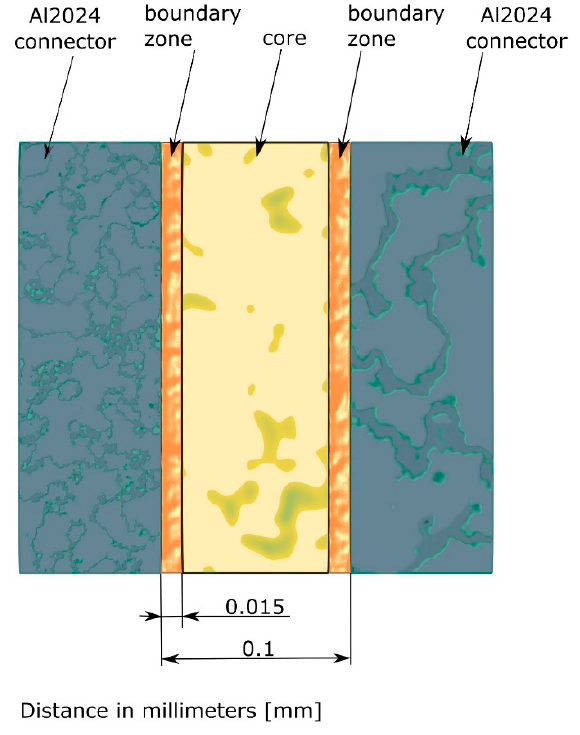
Figure 1. Schematic representation of adhesive joint with indicated zones.